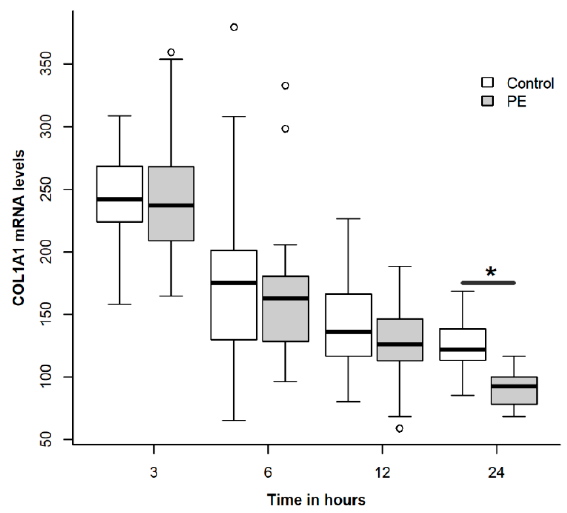
Figure 3. Effect of incubation time of phosphatidylethanolamine (PE) on collagen expression in normal human lung fibroblasts. Cells from passages 5–10 were placed in 6 well plates and when confluence was reached, culture medium was substituted with serum-free medium for 24 h. PE was diluted in F-12 without serum at 50 µg·mL − 1 and cells were incubated for 3, 6, 12 and 48 h. Controls were grown for the same time in F-12 without serum. Asterisk indicates a significant difference when compared with the corresponding control ( p < 0.05, Student t -test).